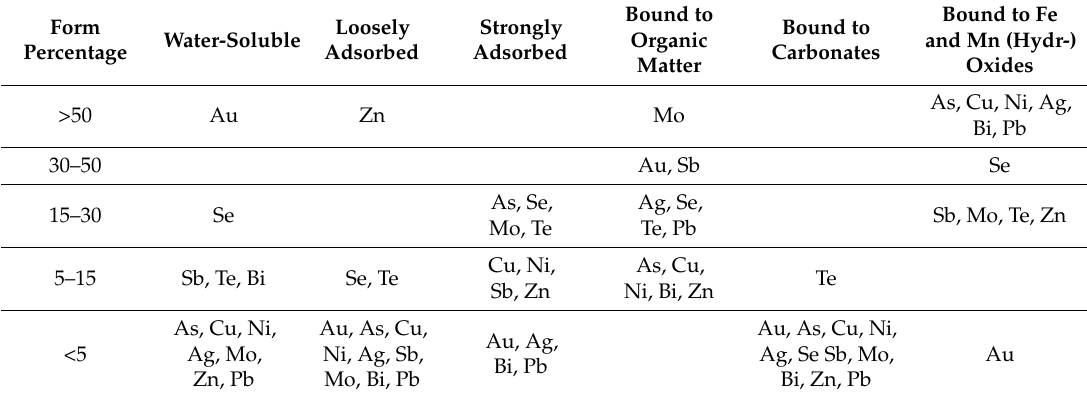
Table 5. Mobile forms of gold and pathfinder elements in surface sediments in the Piilola prospecting